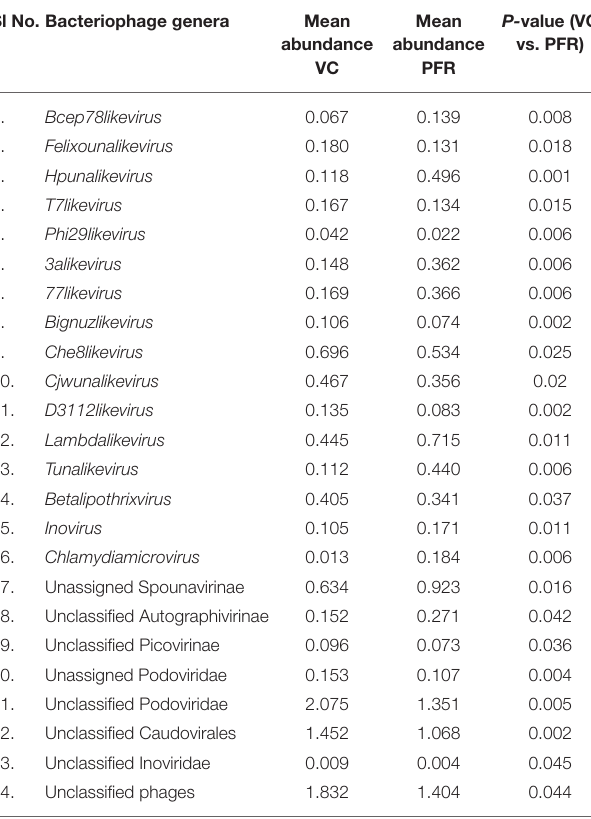
TABLE 2A | Discriminative viral genera in the VC and PFR groups ( P < 0.05). Sl No. Viral genera